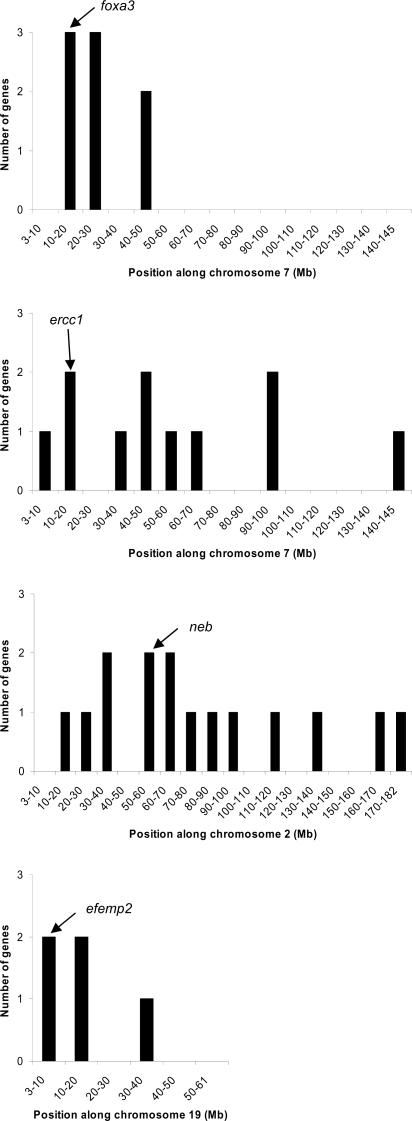
Number of significantly changed genes on targeted chromosome for Foxa3, Neb, Ercc1 and Fibulin-4 mutants.y-axis: number of changed genes, x-axis: chromosomal position. The arrow indicates the location of the mutated genes in each case.